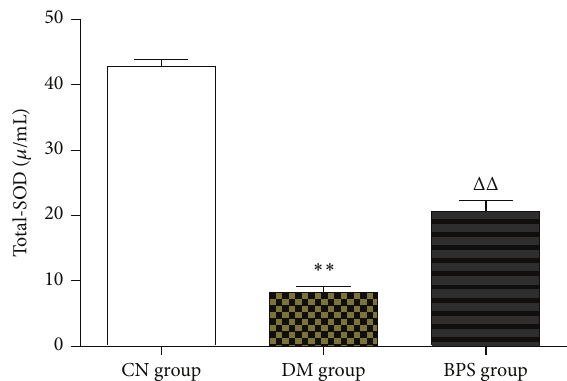
Figure 2: MDA in each group. Compared with CN group, the level of MDA significantly increased in DM group ( 𝑃 < 0.01 ); the level of MDA increased in BPS group, but the difference was not statistically significant ( 𝑃 > 0.05 ). Compared with DM group, the level of MDA significantly decreased in BPS group ( 𝑃 < 0.01 ).